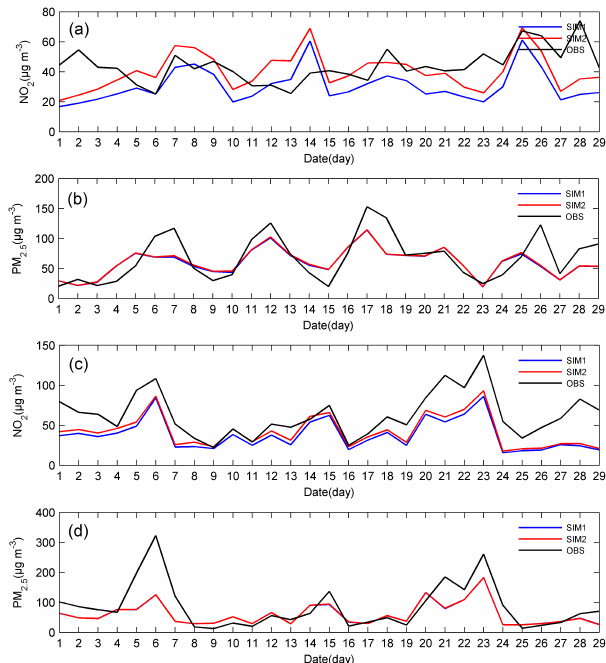
Figure 2. The comparison of site average NO 2 and PM 2 . 5 concen- trations between SIM1, SIM2, and observation in July (a, b) and December (c, d)